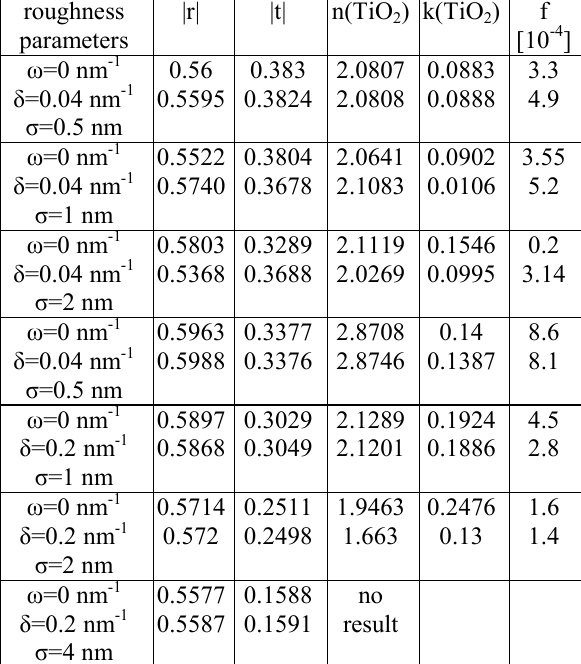
Table 2: Effective parameters evaluation for five-layered structure.